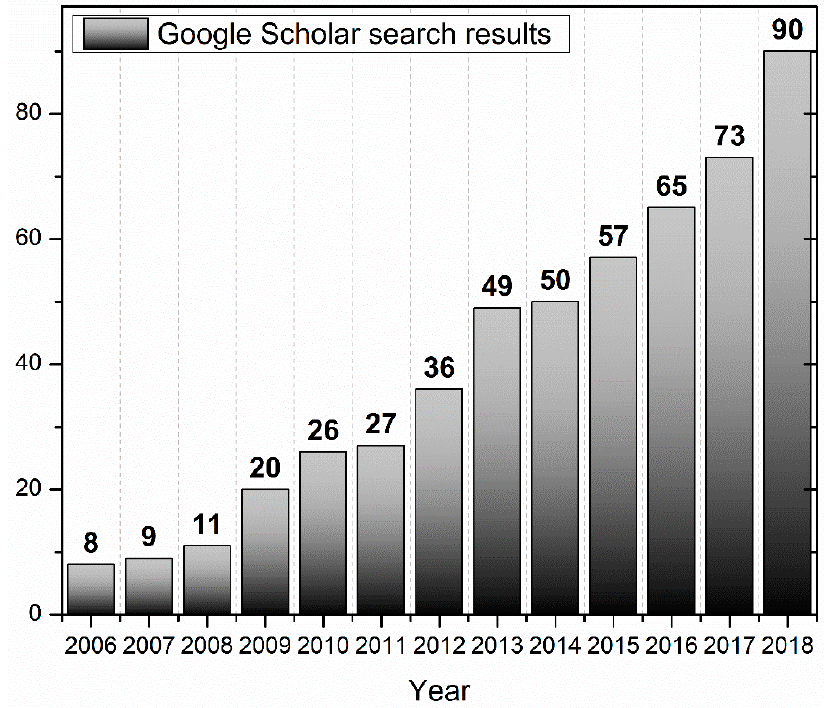
Figure 2. Number of articles published per year mentioning word “aquaphotomics” since 2006. The numbers are obtained using Google Scholar web search engine for articles and patents (excluding citations) containing word “aquaphotomics”.